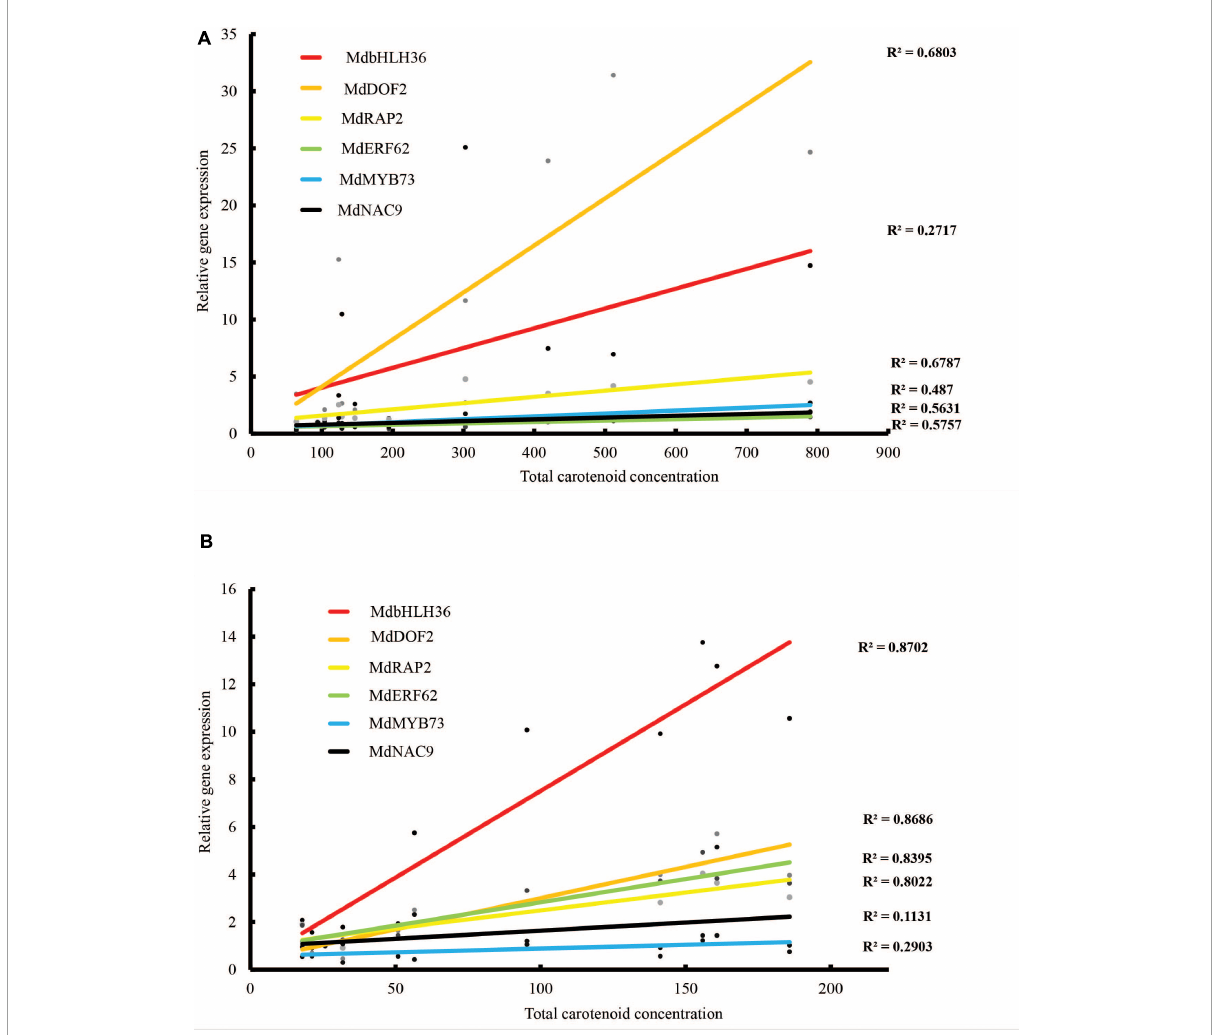
FIGURE8 Correlations between carotenoid content and TF gene expression as determined by qRT-PCR in (A) fruit skin and (B) fruit flesh of WT and PSY fruit. R 2 values indicate coefficient of